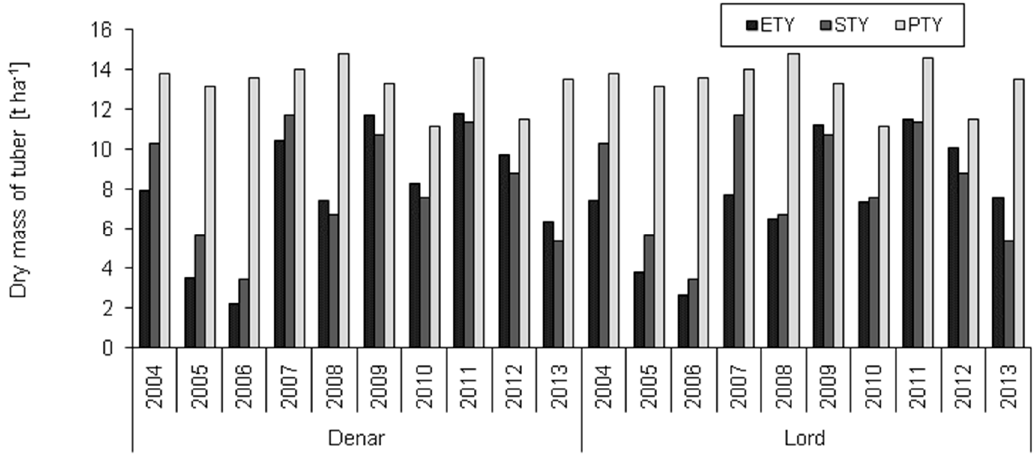
Figure 1. Calibration results of simulated, measured and potential yield of selected cultivars. (* dry matter), ETY—empirical tuber yield*, STY—simulated tuber yield*, PTY—potential tuber yield*.